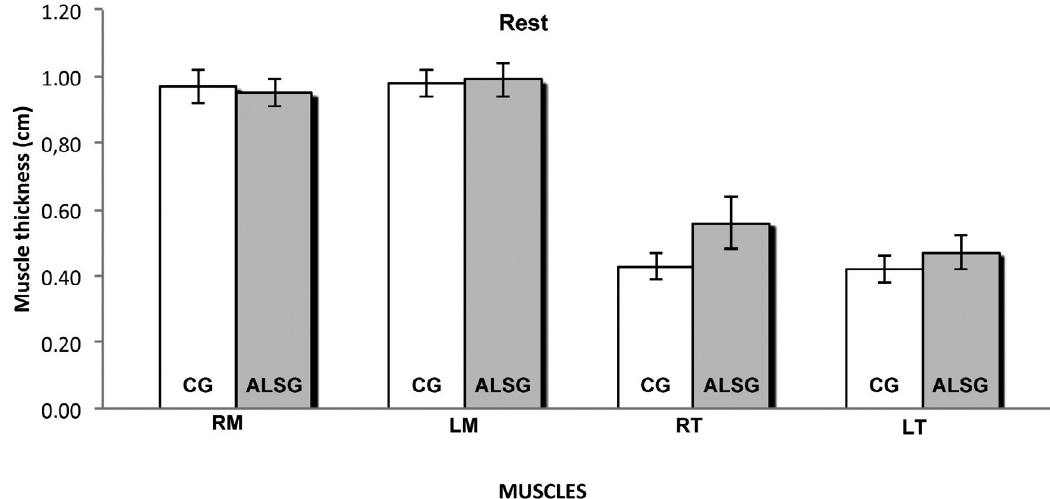
Figure 9- Masticatory muscle’ thickness data of masseter (RM: right masseter; LM: left masseter) and temporalis (RT: right temporal; LT: left temporal) muscles for CG and ALSG in the rest